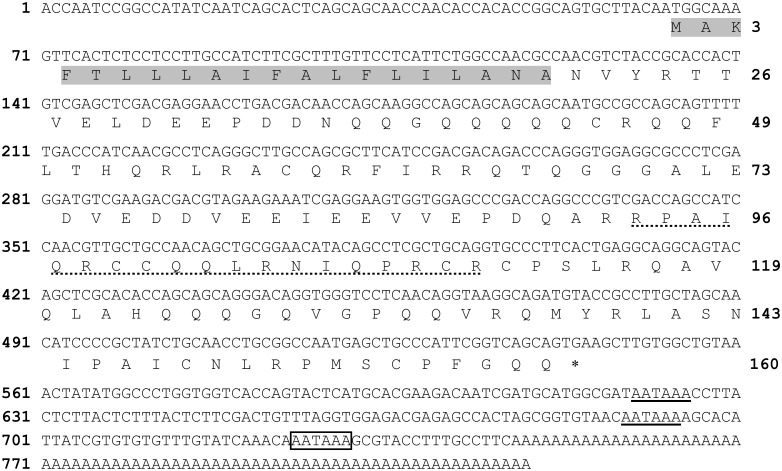
The cDNA sequence and deduced amino acid sequence of preproMo-CBP3–3.The deduced amino acid sequence of the preproMo-CBP3–3 is shown below the cDNA sequence. Numbers for the first nucleotide and the last amino acid residue in each row are shown on the left and right, respectively. The N-terminal signal peptide, as predicted by the SignalP 4.1 program [27], is shaded in gray. The N-terminal sequence of the large chain of Mo-CBP3, as determined by Edman degradation, is underlined with a dashed line. The stop codon is indicated by an asterisk. The poly(A) signal nearest to the poly(A) tail is boxed, and two other upstream poly(A) signals are underlined.